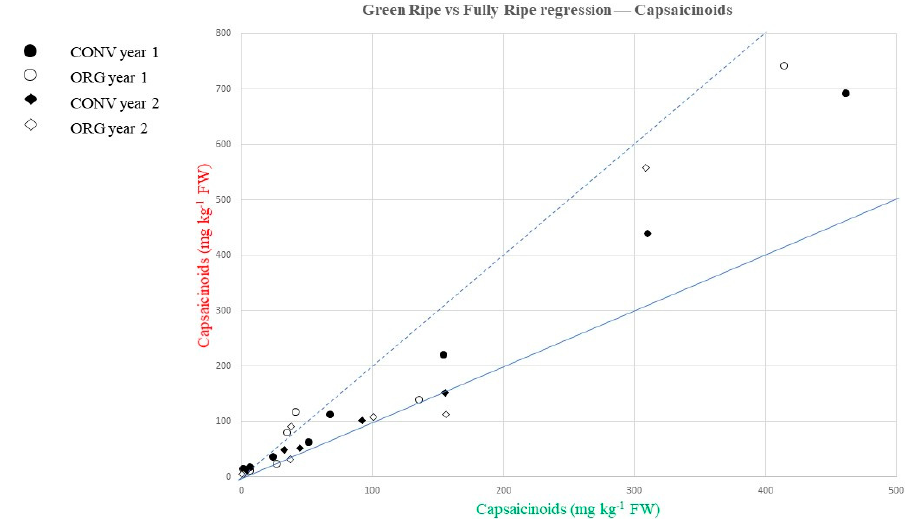
Figure 5. Green-ripe (green) vs. fully ripe (red) means of the studied Capsicum collection for total sugars (upper, g kg − 1 of fw) and total capsaicinoids (bottom, mg kg − 1 of fw) in both years and growing systems. The continuous blue line indicates slope = 1 (i.e., the same value at the green-ripe than the fully ripe stage). The dotted blue line indicates slope = 2 (i.e., the value at the fully ripe stage is 2-fold greater than at the green-ripe stage).